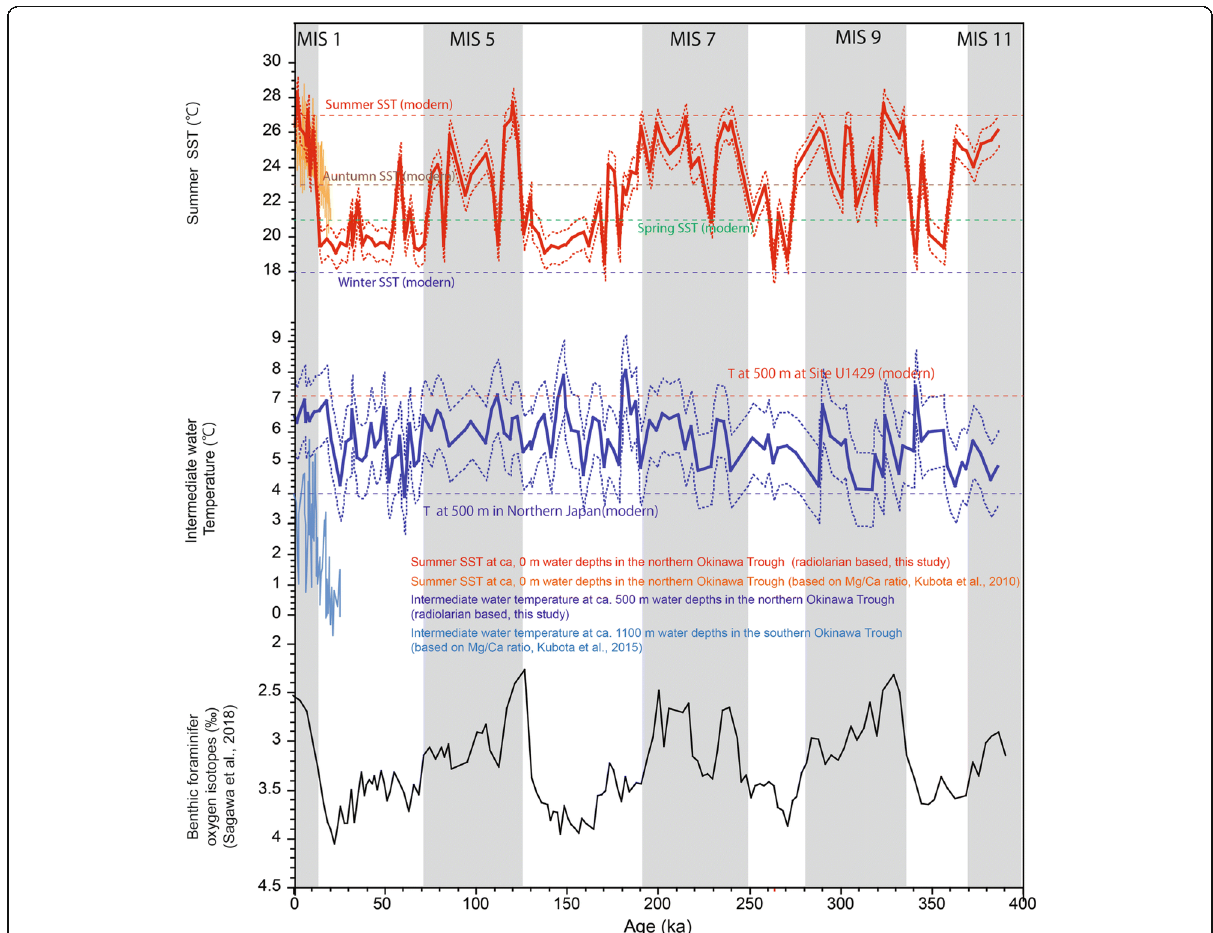
Fig. 6 Radiolarian-based estimates for intermediate water temperature and SST over time and compared to the benthic foraminifera isotope curve of Sagawa et al. (2018). Dashed curves indicate modern median temperatures. Also shown are the summer SST estimated using the Mg/Ca ratio of planktic foraminifera (Kubota et al. 2010) in the northern Okinawa Trough and bottom water temperature estimated using the Mg/Ca ratio of benthic foraminifera in the southern Okinawa Trough (Kubota et al.